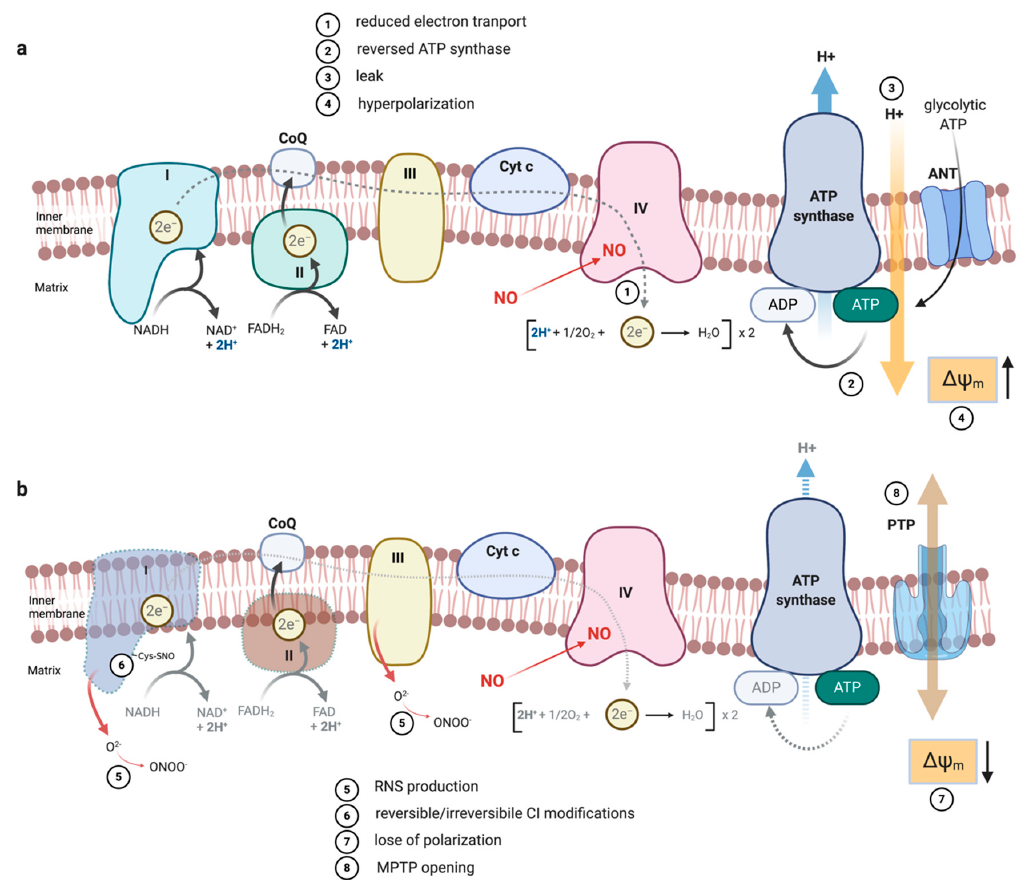
Figure 2. Mitochondrial bioenergetics following acute and prolonged NO injury. ( a ) Cytochrome c oxidase exert considerable control over the rate of respiration because NO increases the K m of the enzyme for O 2 . Inhibition of cytochrome c oxidase by NO leads to a drop in the electron flux and consequently in proton extrusion. This changes the ETC to a more reduced state and leads to a defense response where reversal of the ATP synthase will hydrolyze cytoplasmic glycolytic ATP extruding protons (H + ). This will re-establish the proton leak transiently lost during initial gradient dissipation. The effect of these changes is a hyperpolarization of the inner mitochondrial membrane. ( b ) Prolonged exposure to NO and, therefore, persistent inhibition of respiration by NO favors the formation of superoxide anions (O 2 − ) and peroxynitrite (ONOO – ), from the reaction between superoxide and NO, resulting from changes in intracellular redox conditions and depletion of the glutathione pool. These species can activate mechanisms that lead to irreversible damage, like deleterious modifications of CI. This situation facilitates the induction of the permeability transition pore (PTP), which leads to the collapse of the membrane potential and cell death. The passage of electrons (e – ) along the ETC is depicted. Cyt c, cytochrome c; FADH 2 , flavin-adenine dinucleotide reduced; NADH, nicotinamide adenine dinucleotide reduced; Q, ubiquinone; I, II, III, and IV refer to the complexes of ETC. ANT, adenosine nucleotide translocator.